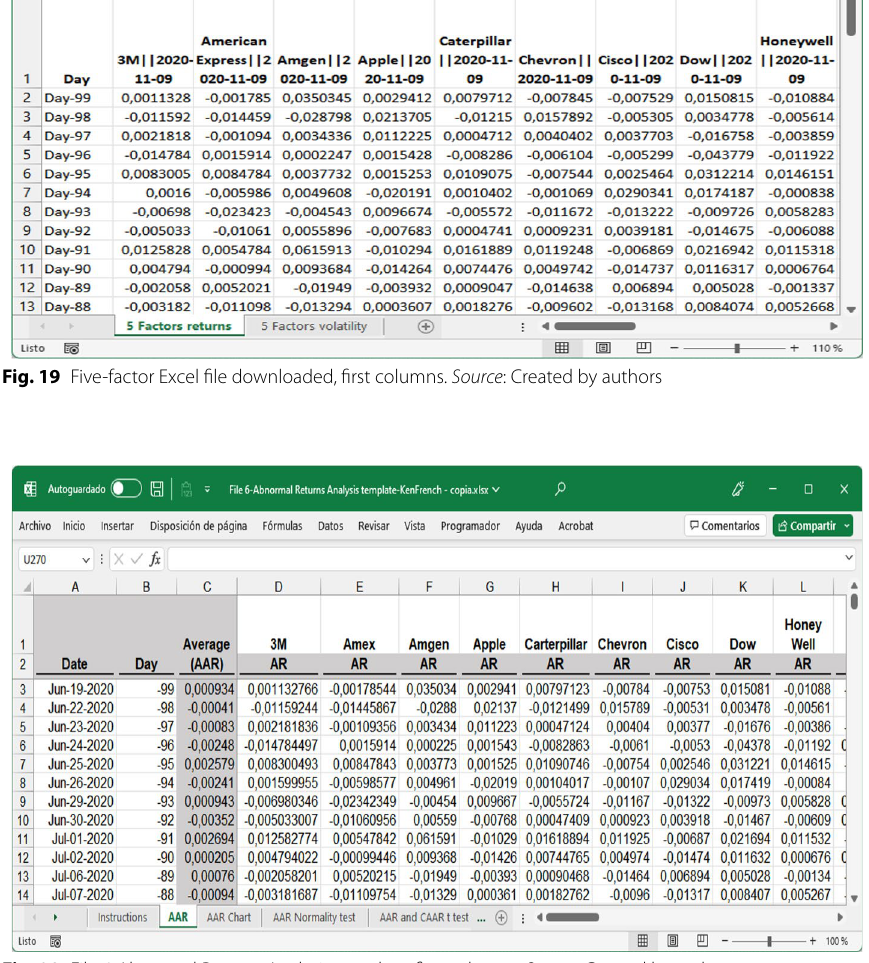
Fig. 20 File 6‑Abnormal Returns Analysis template, first columns. Source : Created by